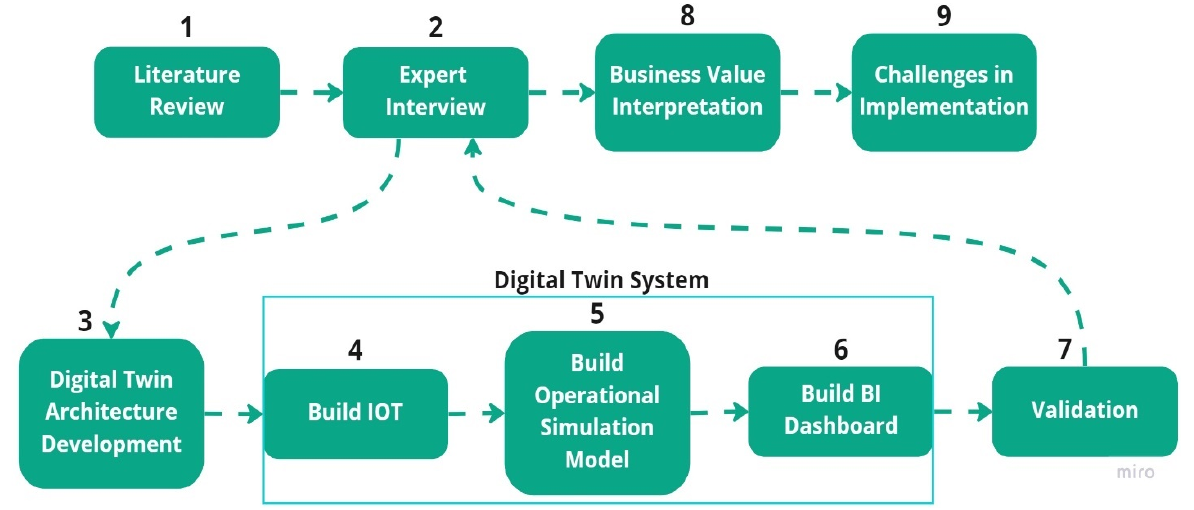
Figure 4. Methodology Framework.